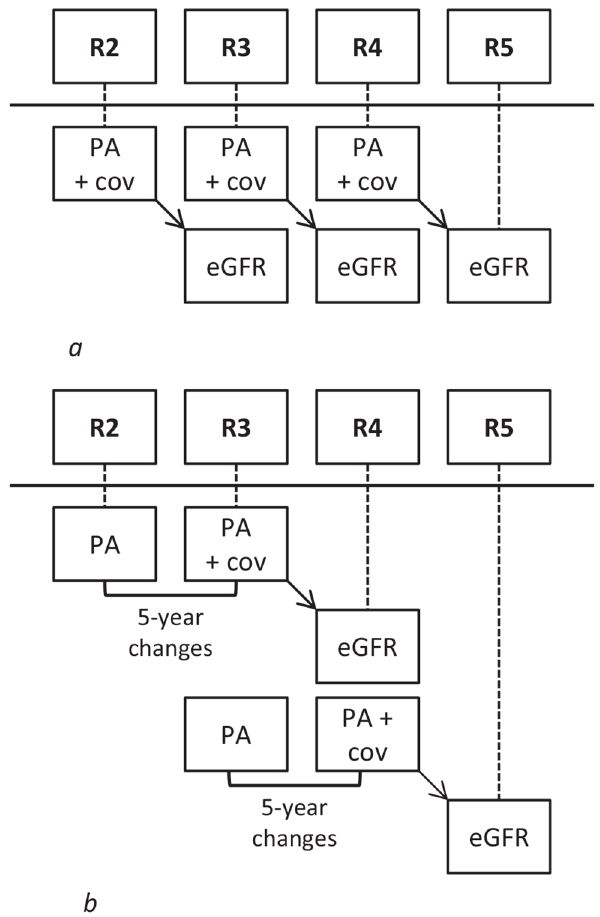
Fig 1. Visualizing the generalized estimating equation regression models with time lag between a ) physical activity and estimated glomerular filtration rate and b ) 5-year changes in physical activity and estimated glomerular filtration rate. Abbreviations: R2: round 2, R3: round 3 etc. PA: physical activity, eGFR: estimated glomerular filtration rate. Cov: covariates.